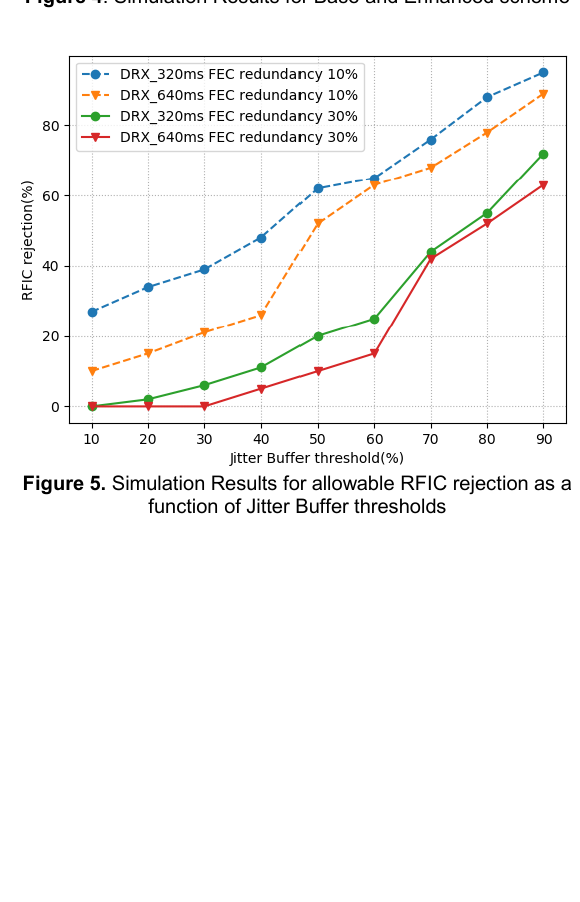
Figure 4 . Simulation Results for Base and Enhanced scheme